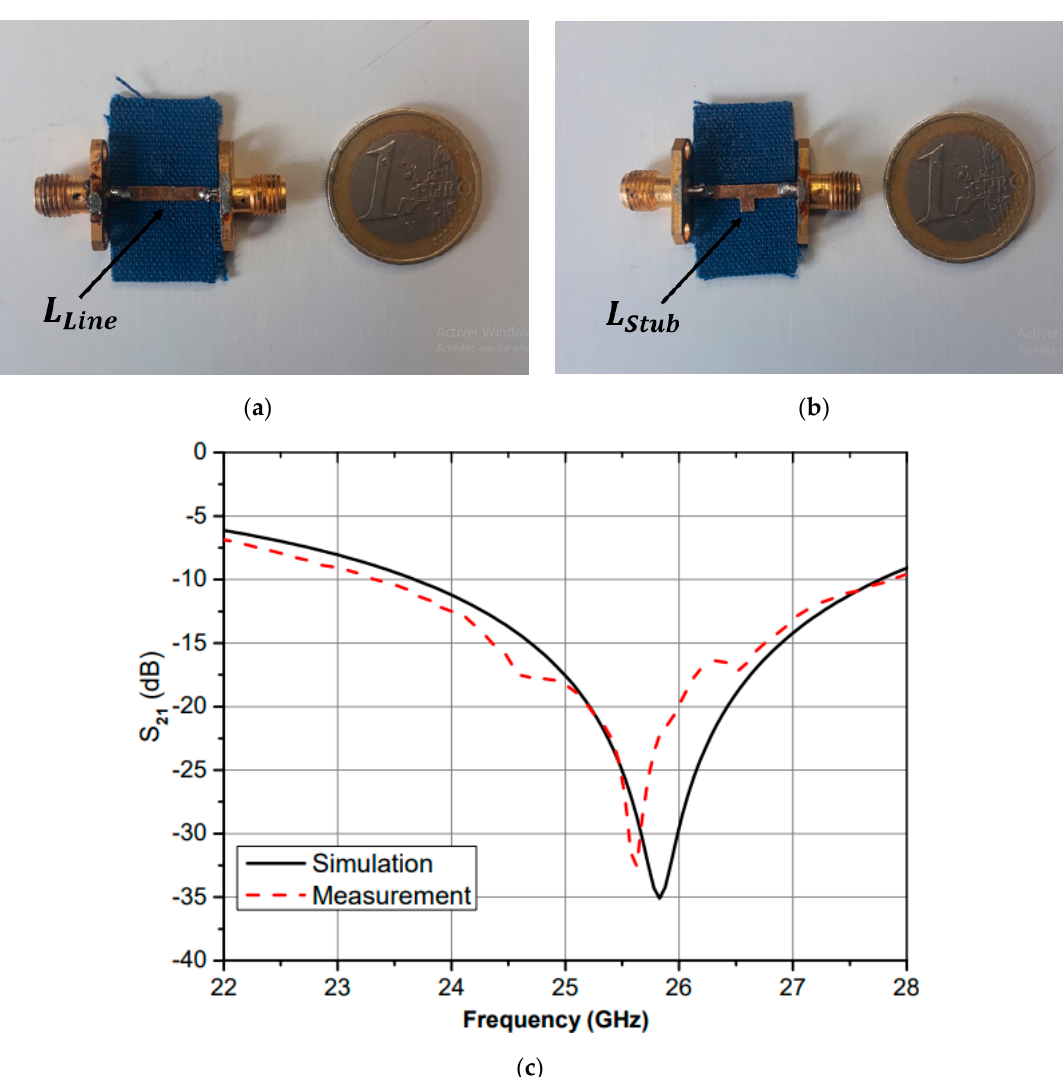
Figure 1. Characterization of the polyester fabric at 26 GH. ( a ) Prototypes of the microstrip line and microstrip T-resonator. ( b ) Set-up of S-parameter measurement. ( c ) Simulation and measurement results of S 21 parameter.